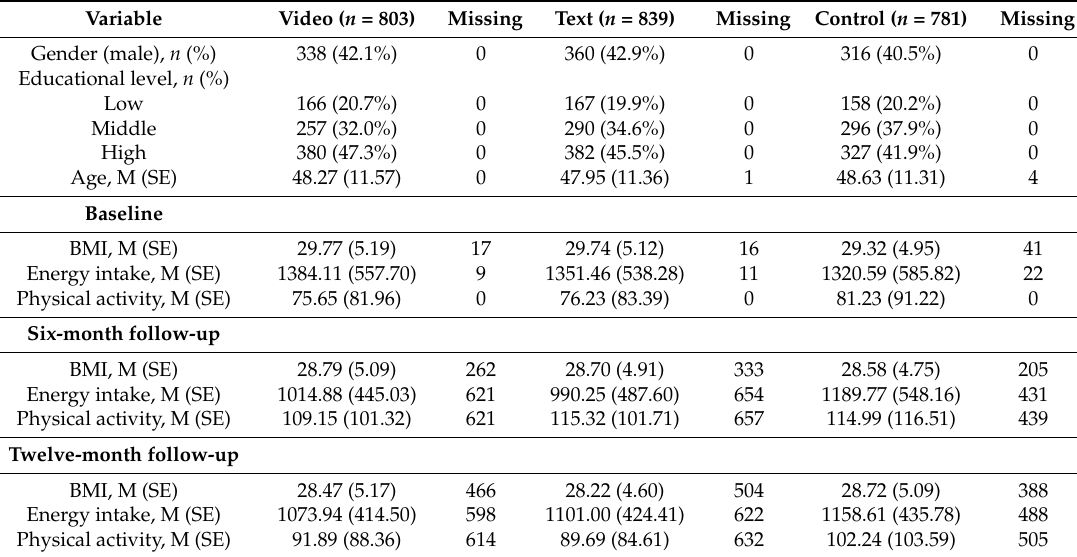
Table 1. Baseline sample characteristics and outcome estimates at baseline and